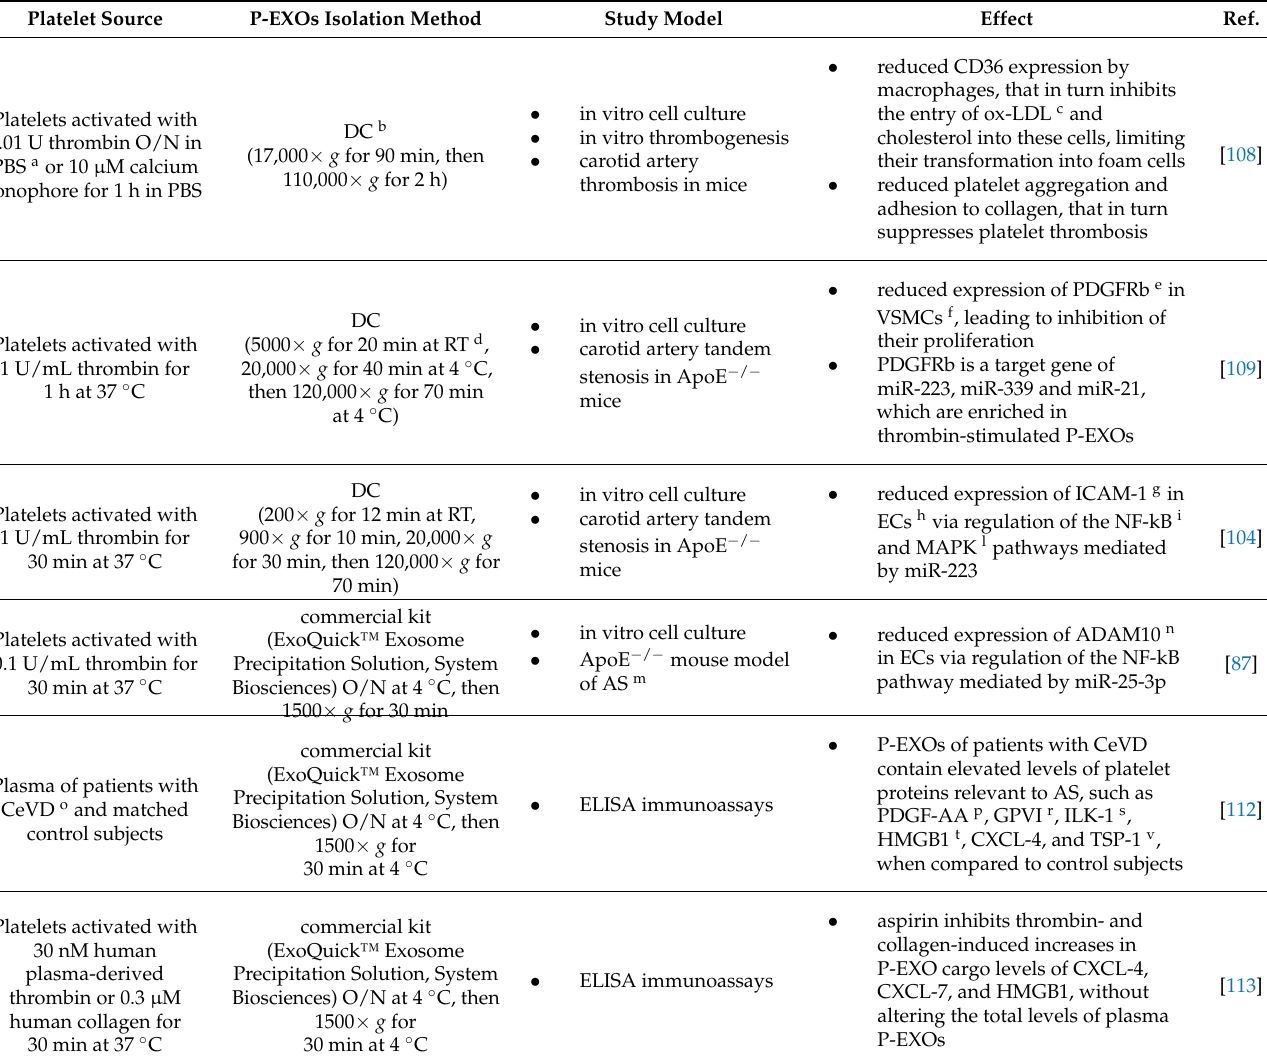
Table 1. Role of P-EXOs in AS and